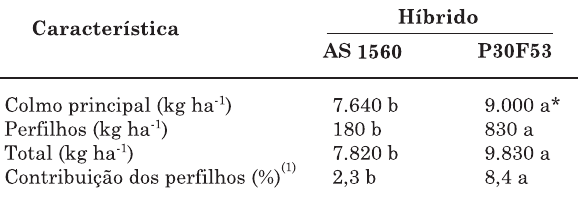
grãos. Linhas tracejadas e losangos representam o rendimento de grãos do colmo